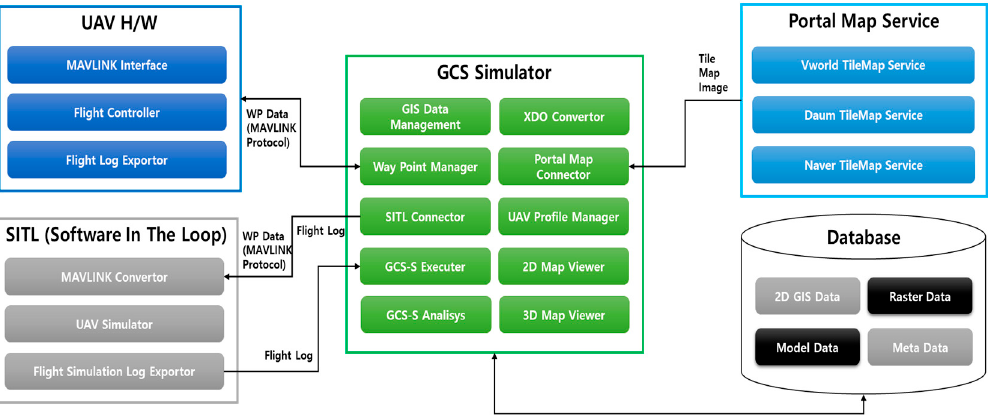
Figure 2. Architecture and modules of the simulator.